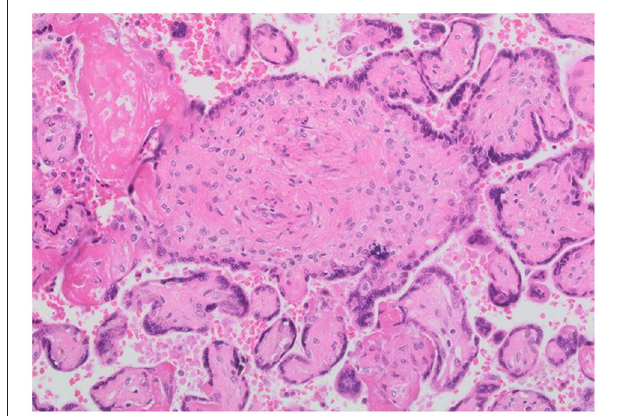
FIGURE 1 | Representative images of fetal placental vascular circulation abnormalities. Villous changes consistent with fetal thrombo-occlusive disease.